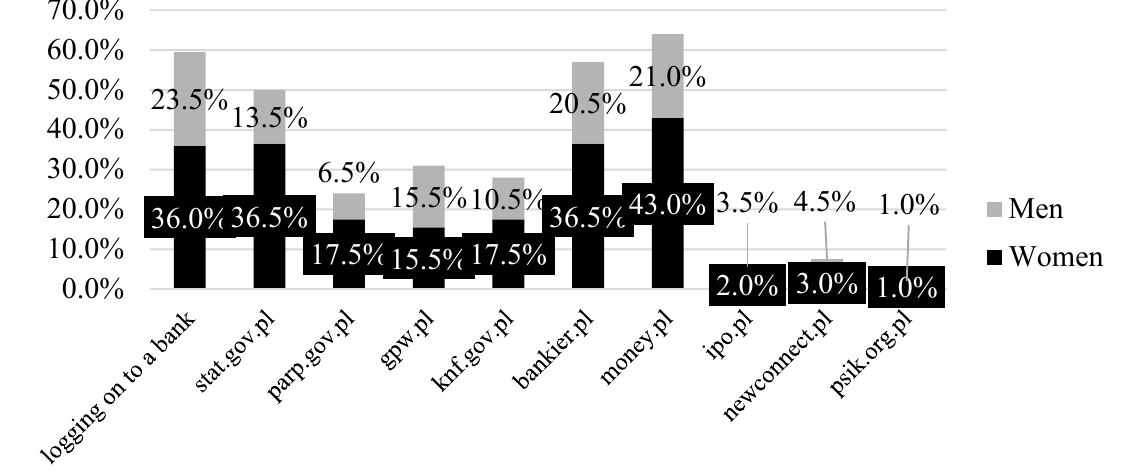
Figure 3. Structure of financial market websites used by women and men. Source: Own